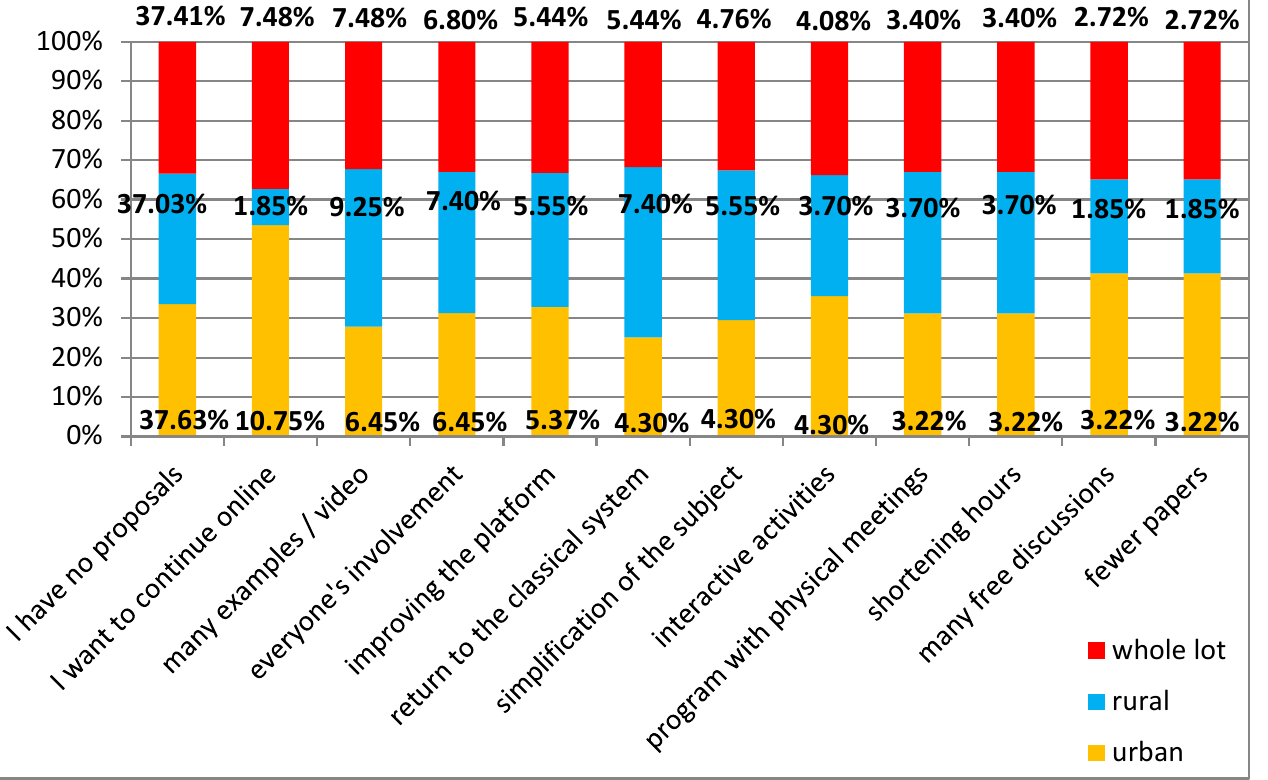
Figure 3. Graphical representation of the main proposals for streamlining online teaching activities.